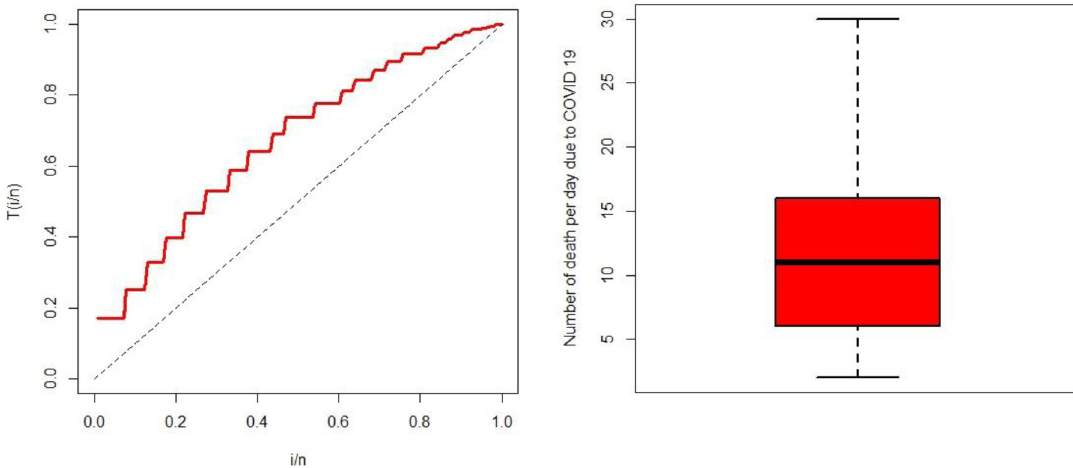
Fig 2. TTT plot (left panel) and box plot (right